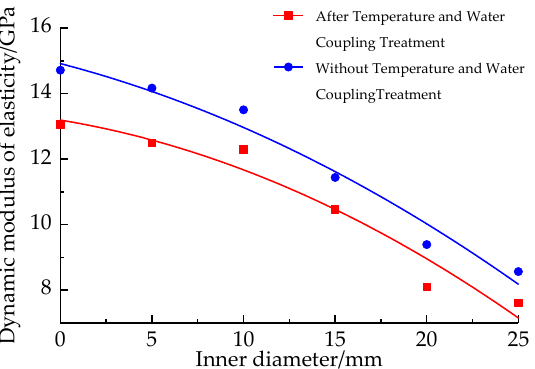
Figure 12. Relationship between dynamic elastic modulus and annular diameter change. The fitting formula is shown in Formula (8). The correlation coefficients were 0.9178 and 0.9537. The dynamic elastic moduli of intact sandstone specimens are the largest, which are 7.60 GPa and 8.56 GPa.